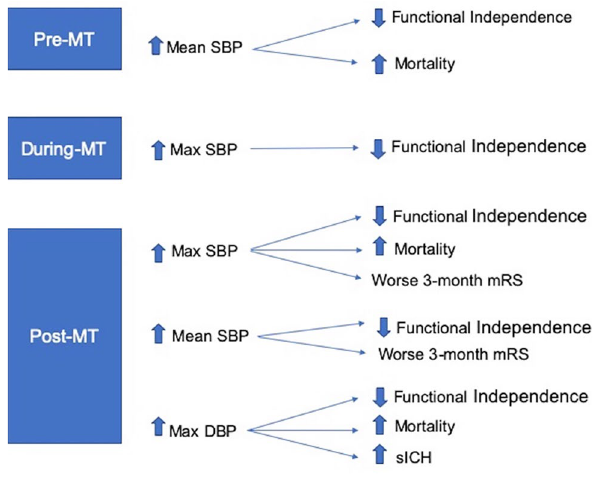
Fig. 5 Association of blood pressure and outcome before, during, and after mechanical thrombectomy. (From Malhotra K, Goyal N, Katsano AH, et al. Hypertension 2020;75:730–739 with permission from the pub- lisher, https://www.ahajournals.org/doi/full/https://doi.org/10.1161/